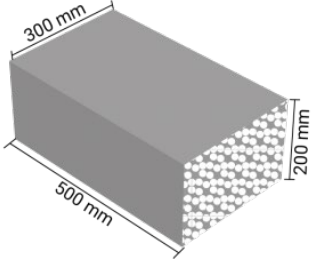
Fig. 2. High-Performance Foam concrete block with foam glass aggregate (Sample